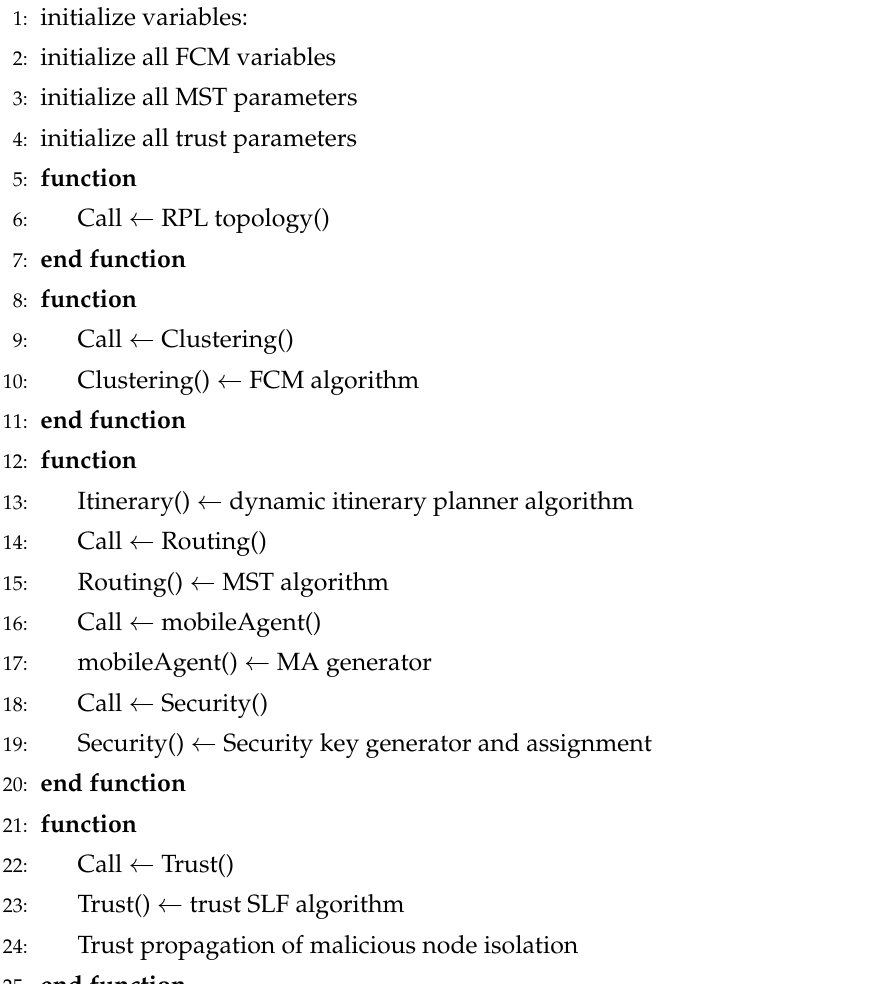
Algorithm 5 RPL-based trust